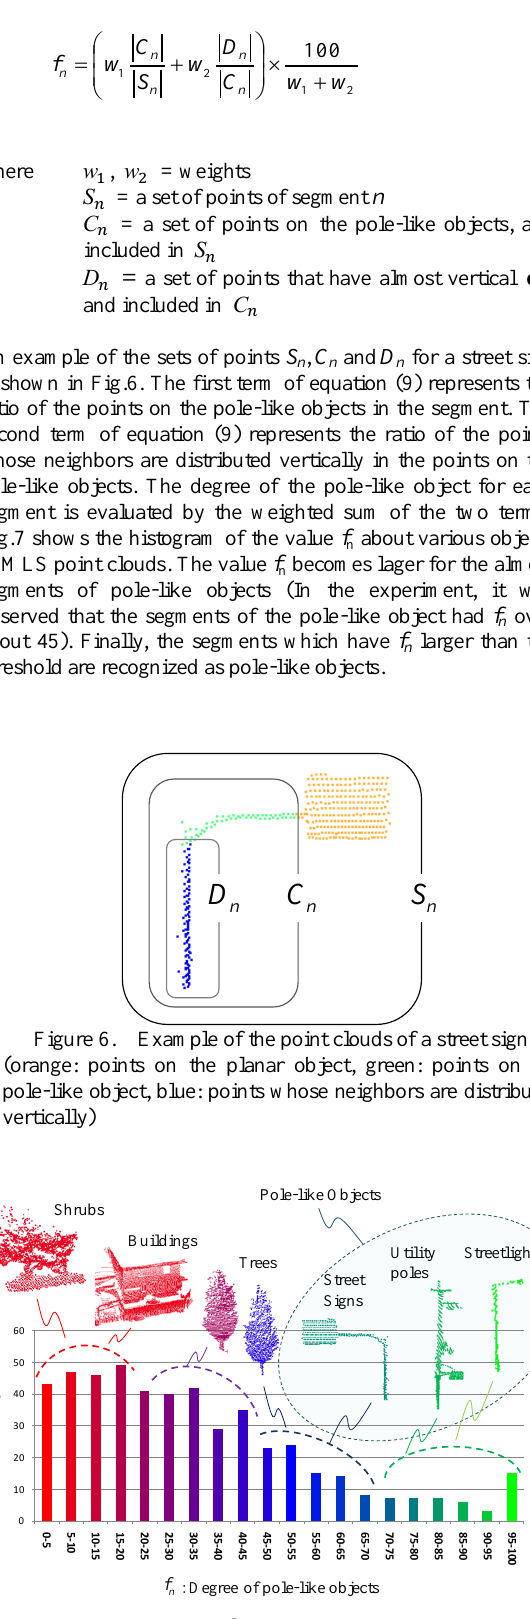
Figure 7. Histogram of f n , and objects in MLS point clouds